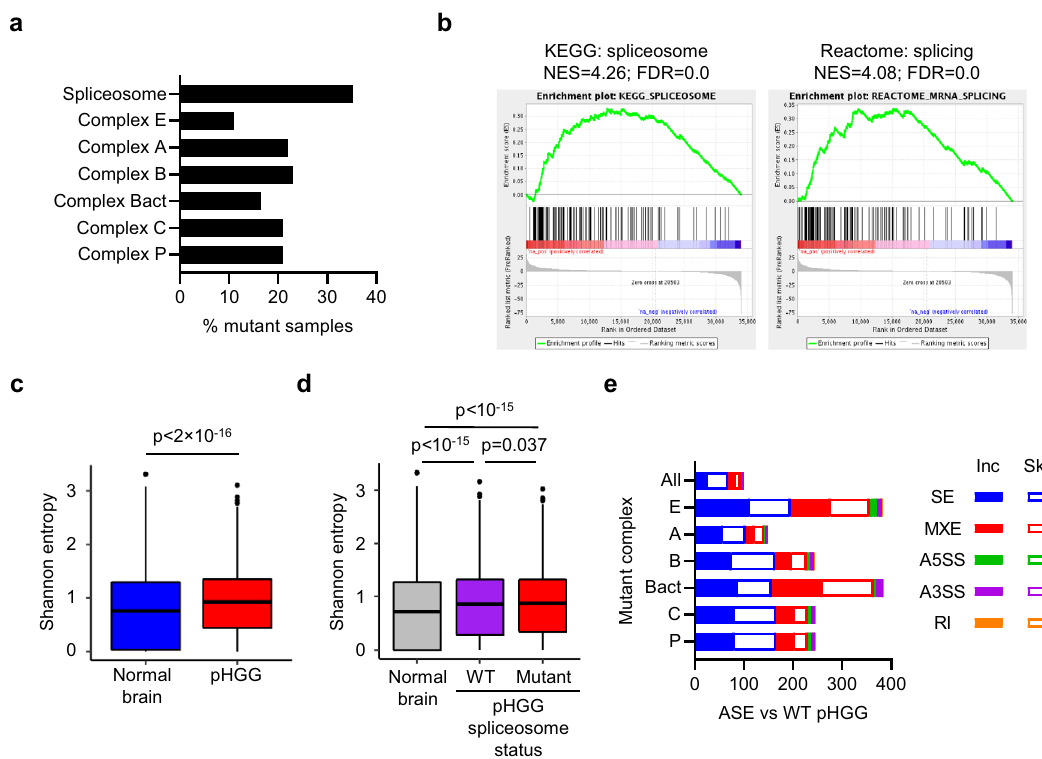
Fig. 1 The landscape of alternative splicing in pHGG. a Frequency of spliceosome mutations in pHGG in total (Spliceosome) and by subcomplex. b Gene set enrichment analysis (GSEA) comparing pHGG ( n = 64) and normal brain ( n = 20) for spliceosome components and mRNA splicing pathway. NES normalized enrichment score, FDR false discovery rate. c Splicing burden, as measured by the median Shannon entropy of multi-isoform genes, was plotted for normal brain ( n = 20) and pHGG ( n = 64). The box shows the interquartile range (IQR), the line shows the median, and the whiskers extend to 1.5×IQR. d Splicing burden was plotted for normal brain ( n = 20) plus pHGG with wild-type (WT, n = 24) or mutant ( n = 28) spliceosomes. The box shows the interquartile range (IQR), the line shows the median, and the whiskers extend to 1.5×IQR. e Differential splicing events (ASE; splice change| Δψ |>0.15, FDR < 0.05) were identi fi ed in pHGG with mutations in each spliceosome complex relative to pHGG with WT spliceosomes. Each bar shows the number of each type of event that was preferentially included (Inc) or skipped in mutant pHGG. SE skipped exon, MXE mutually exclusive exon, A5SS alternative 5 ’ splice site, A3SS alternative 3 ’ splice site, RI retained intron (see Supplementary Fig. S2a for schematic). Statistical tests: Wilcoxon rank-sum test ( c ), Pairwise Wilcoxon rank-sum tests with Benjamini – Hochberg correction ( d ). Source data are provided as a Source Data fi